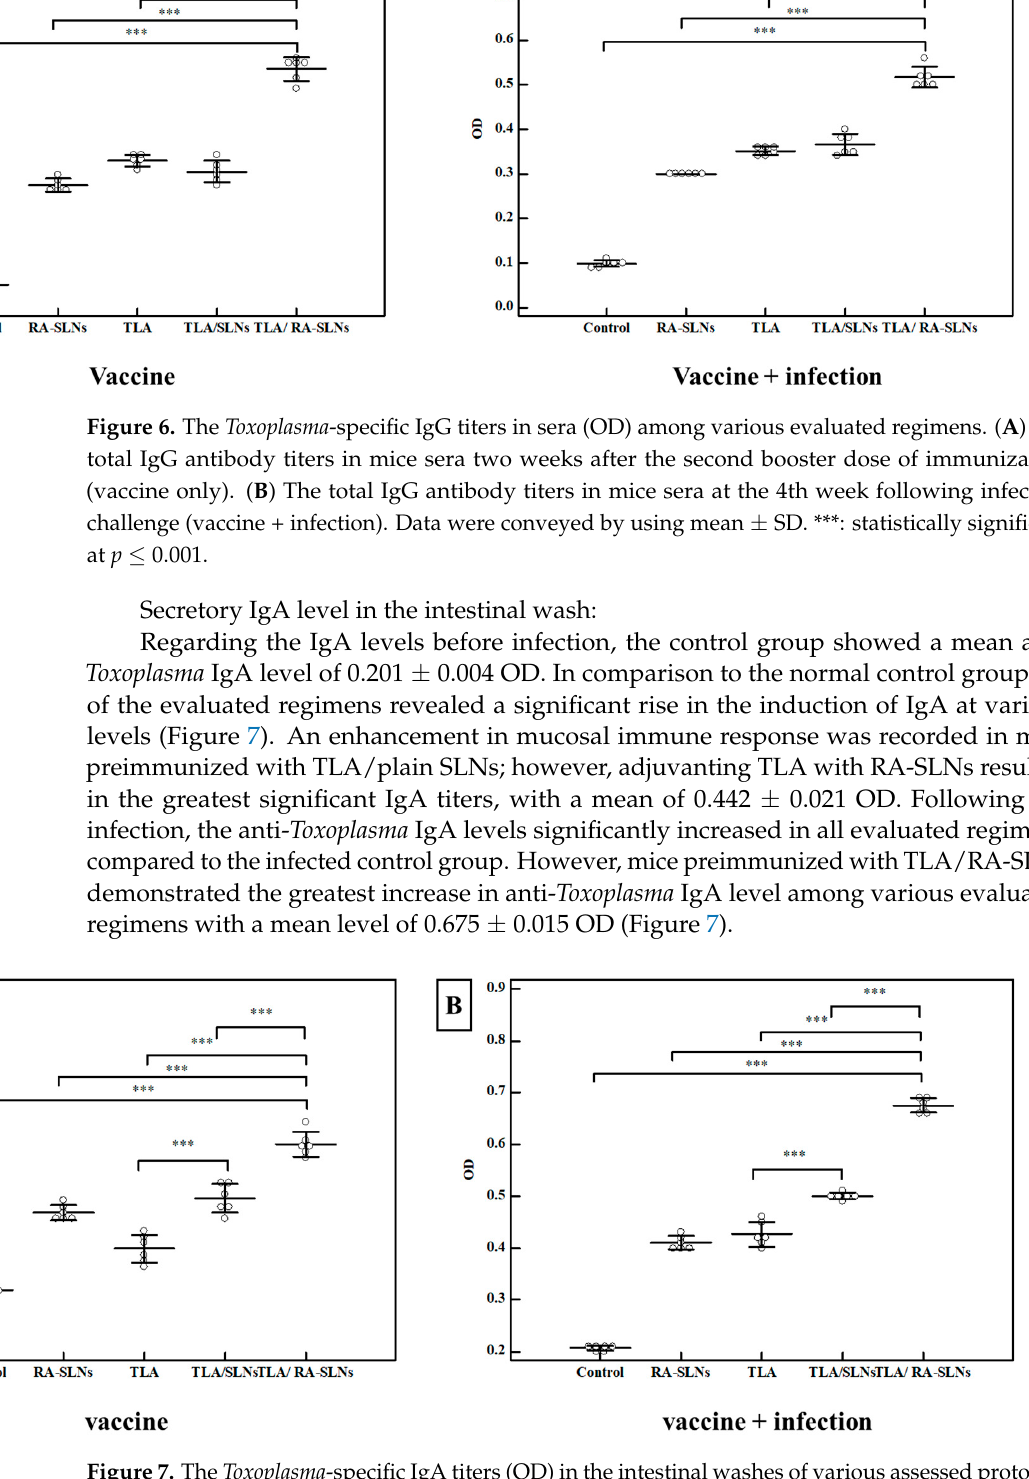
Figure 7. The Toxoplasma- specific IgA titers (OD) in the intestinal washes of various assessed pro- tocols. ( A ) Toxoplasma S-IgA antibody titers in mice two weeks following immunization schedule’s completion (vaccine only). ( B ) Toxoplasma S - IgA antibody titers in mice at week 4 after infection (vaccine + infection). Data were conveyed by using mean ± SD. ***: statistically significant at p ≤